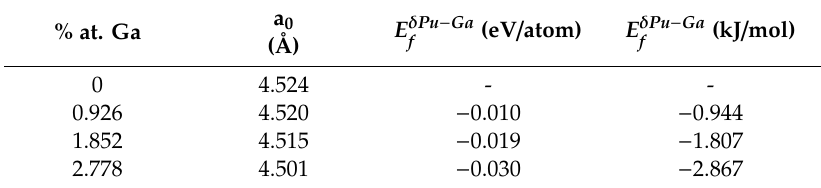
Table 1. Equilibrium lattice constants and formation energies ( E δ Pu − Ga 1.852, and 2.778 at. % Ga δ -Pu